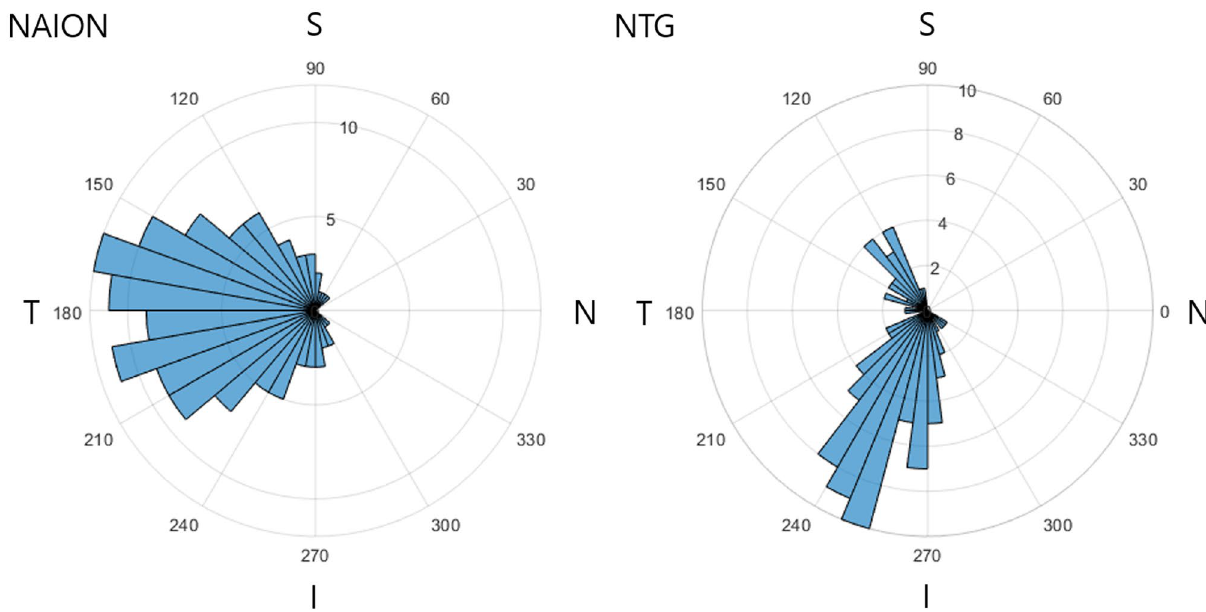
Figure 1. Frequency distribution polar plots of the location of choroidal microvasculature dropout assessed by optical coherence tomography angiography in eyes with nonarteritic anterior ischemic optic neuropathy (NAION) or normal-tension glaucoma (NTG). S, Superior sector; N, Nasal sector; I, Inferior sector; T, Temporal